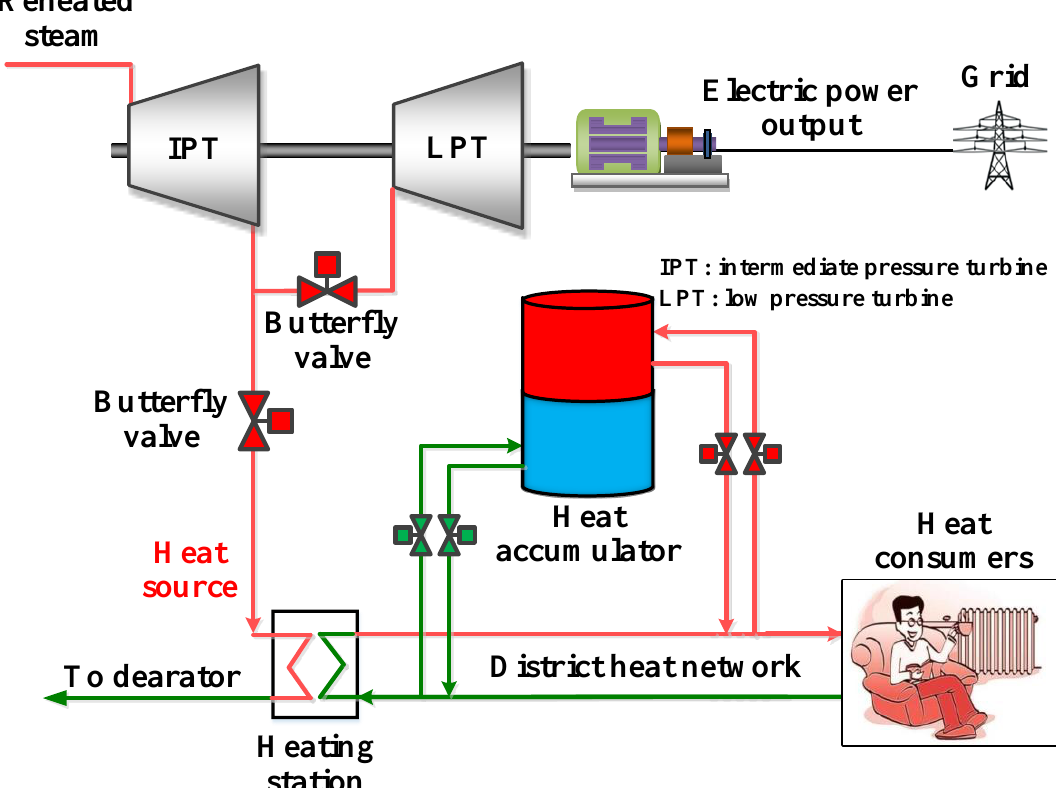
Figure 1. Schematic diagram for the CHP with HA.